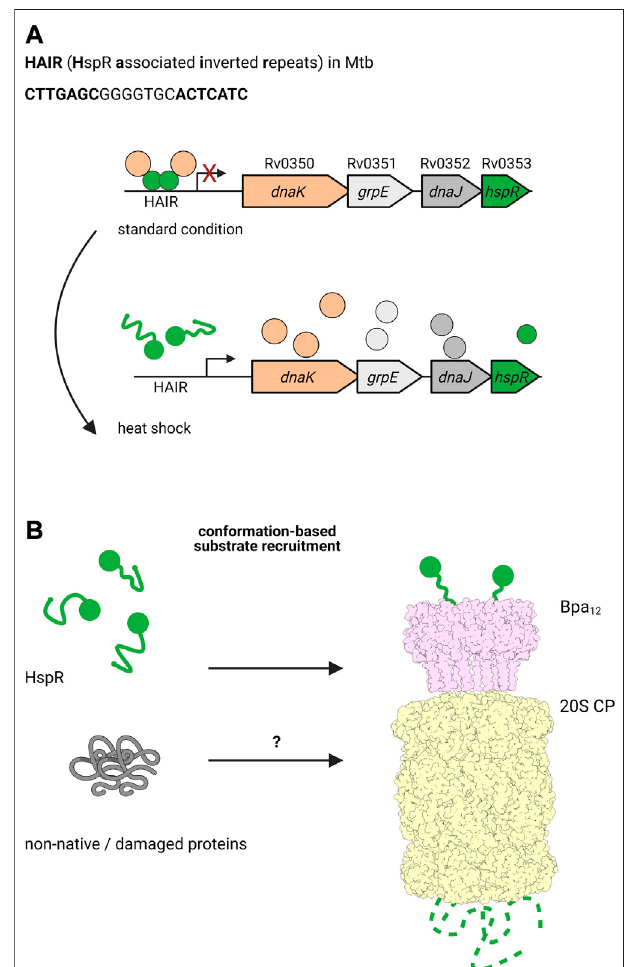
FIGURE 4 | The ATP-independent proteasomal activator Bpa plays a role during heat shock in Mtb. (A) Under standard conditions, the heat shock chaperone DnaK co-represses the transcription of the dnaKJgrpE-hspR operontogetherwiththetranscriptionalregulatorHspR,whichbindsthe HAIR motif operator. Upon heat shock, HspR is partially denatured and dissociates off the promoter to allow transcription of dnaK , grpE , dnaJ and hspR , ultimately leading to production of the encoded proteins. (B) HspR (green) is a substrate for the ATP- and pupylation-independent proteasomal degradation facilitated by Bpa (light pink). Bpa assembles into a homo- dodecameric ring and interacts with the 20S proteasome (light yellow) by inserting its C-terminal GQYL motif into binding pockets between the α -subunits of the core particle. Though there is no overall homology to Mpa/ ARC, the GQYL motif is shared between both proteasomal